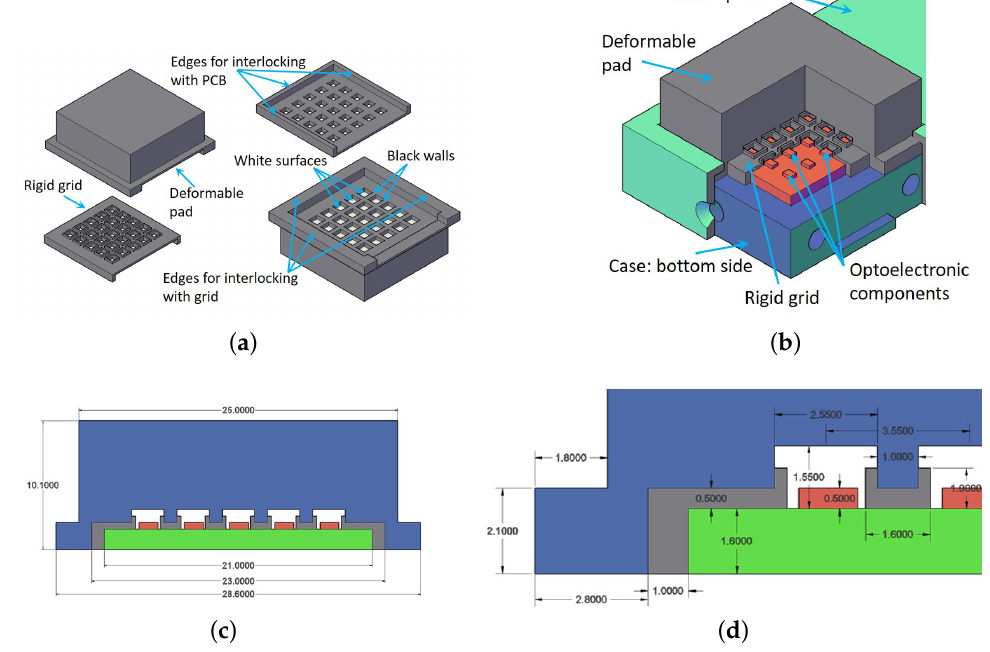
Figure 4. Deformable layer and rigid grid characteristics ( a ). Mechanical assembly of mechanical and electronic parts ( b ). Section of the assembled parts with dimensions: full view ( c ) and zoom view ( d